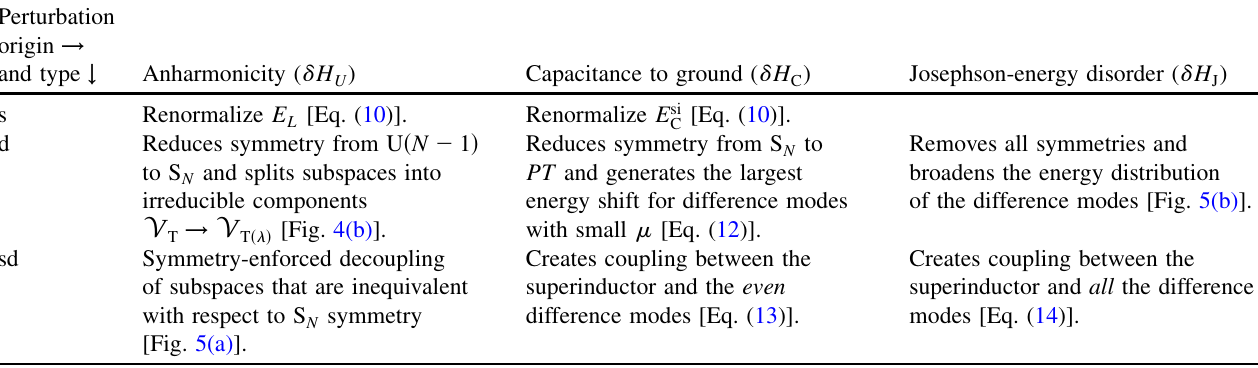
TABLE I. Summary of the principal effects of the perturbations (cid:8)H U , (cid:8)H types of coupling are ‘‘s,’’ coupling among superinductance states; ‘‘d,’’ coupling among difference-mode states; and ‘‘sd,’’ coupling between the two